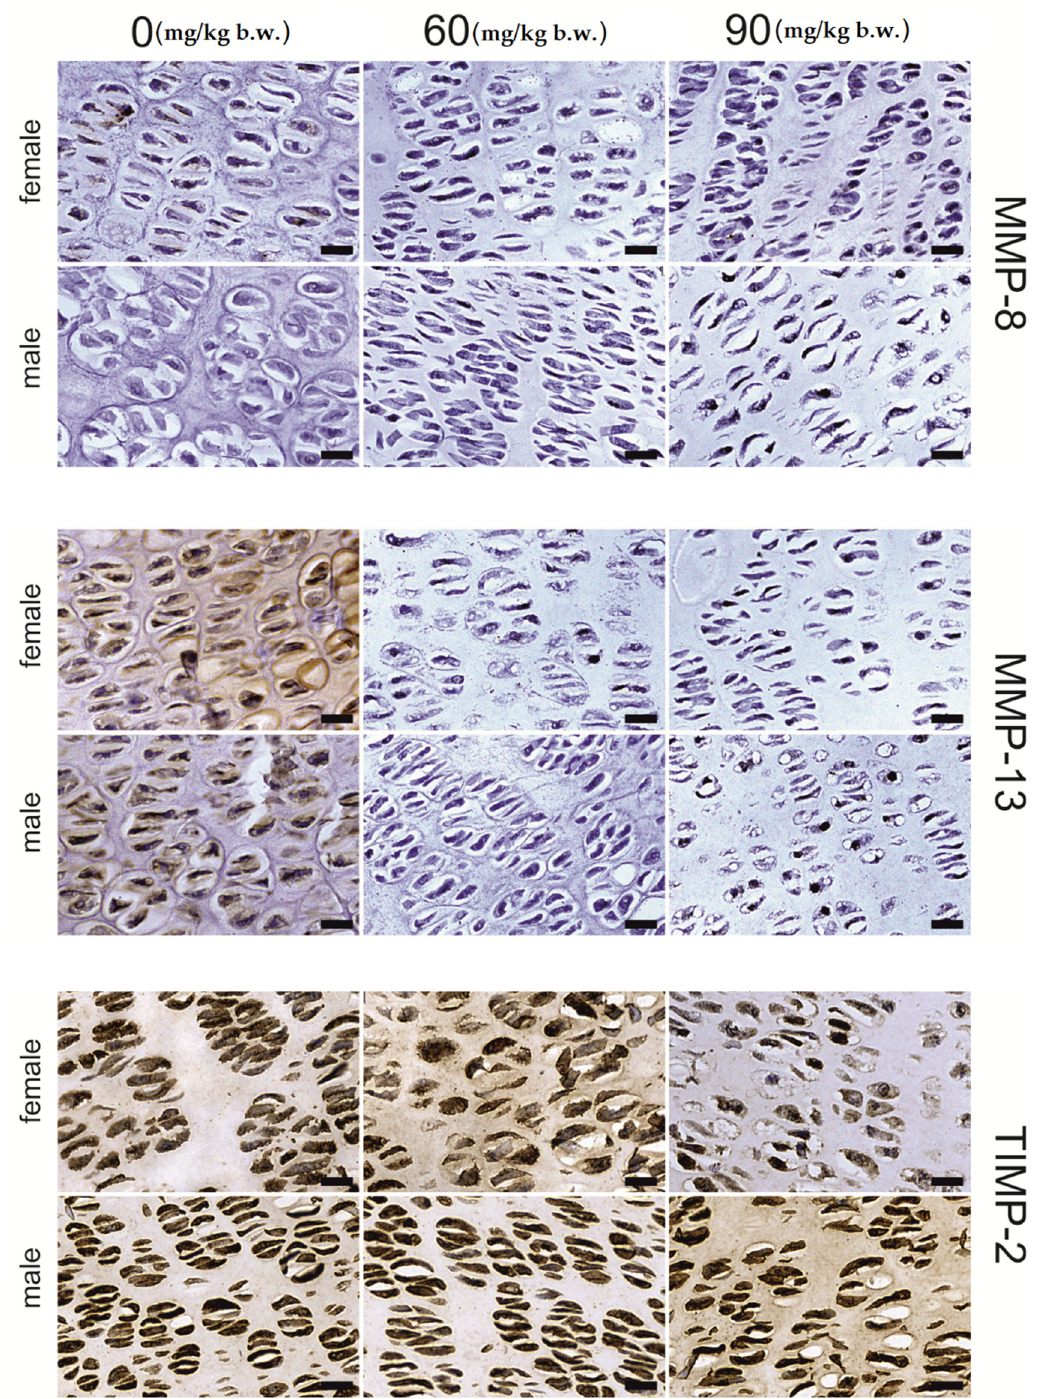
Figure 2. Representative images of the immunohistochemical reactions for MMP-8, MMP-13 and TIMP-2 from the proliferative zone of femoral growth plate of newborn rats (female and male) exposed prenatally to 0, 60 and 90 mg/kg b.w. of fumonisins. All the scale bars represent 20 μ m.